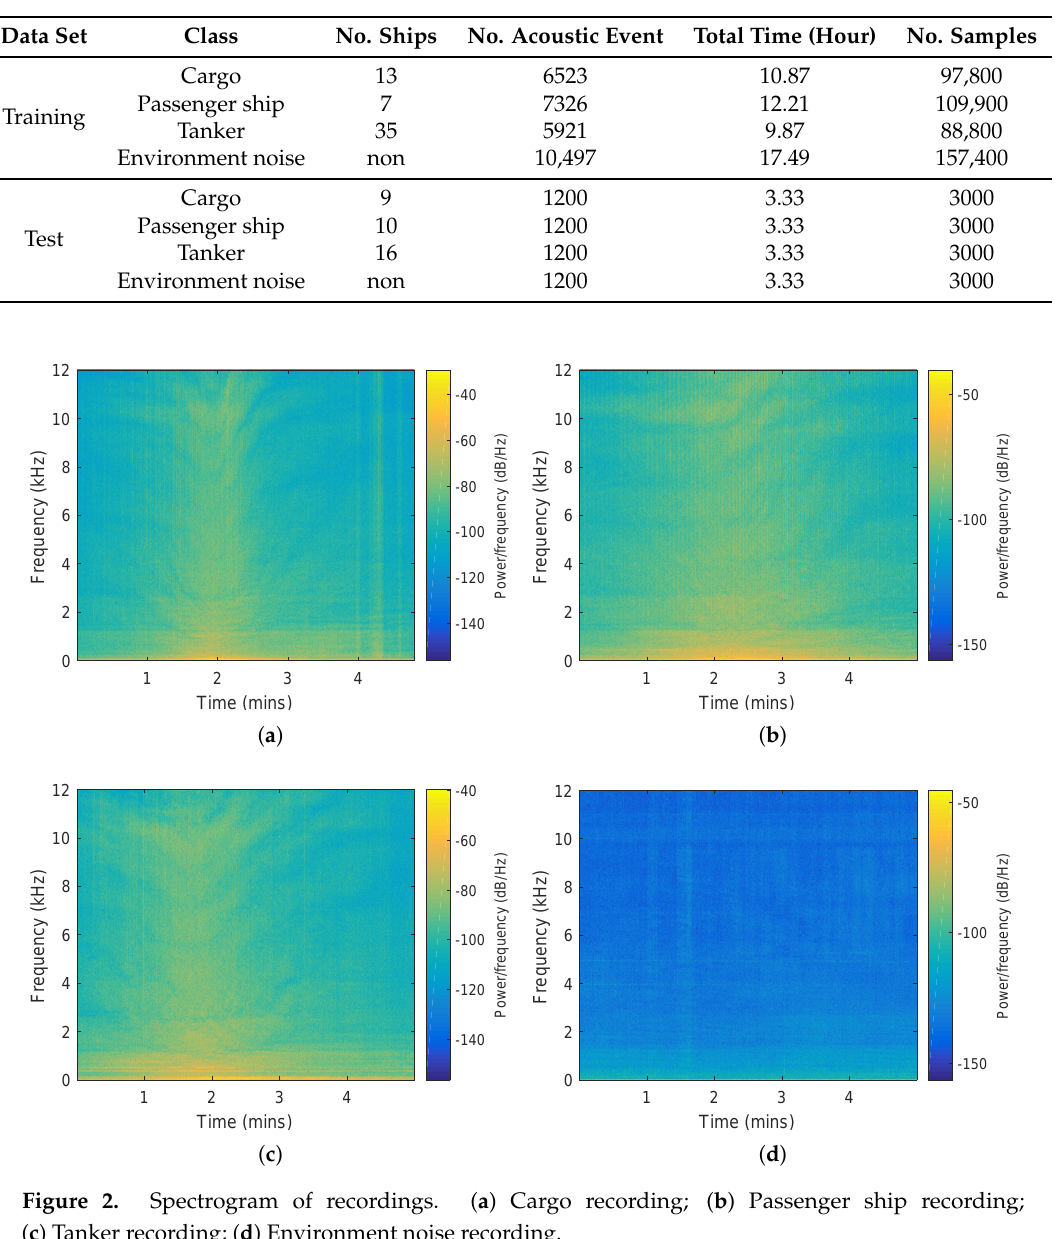
Table 2. Experimental data description.